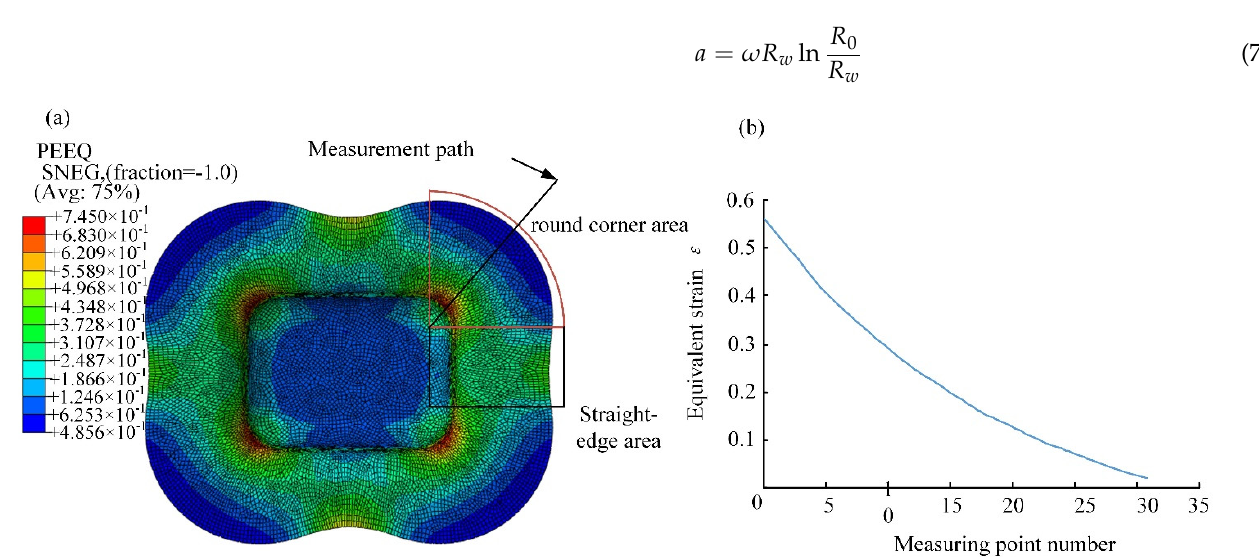
Figure 3. FE simulation of box-shaped part drawing. ( a ) Cloud diagram of equivalent strain; ( b ) equivalent strain distribution of measurement path.